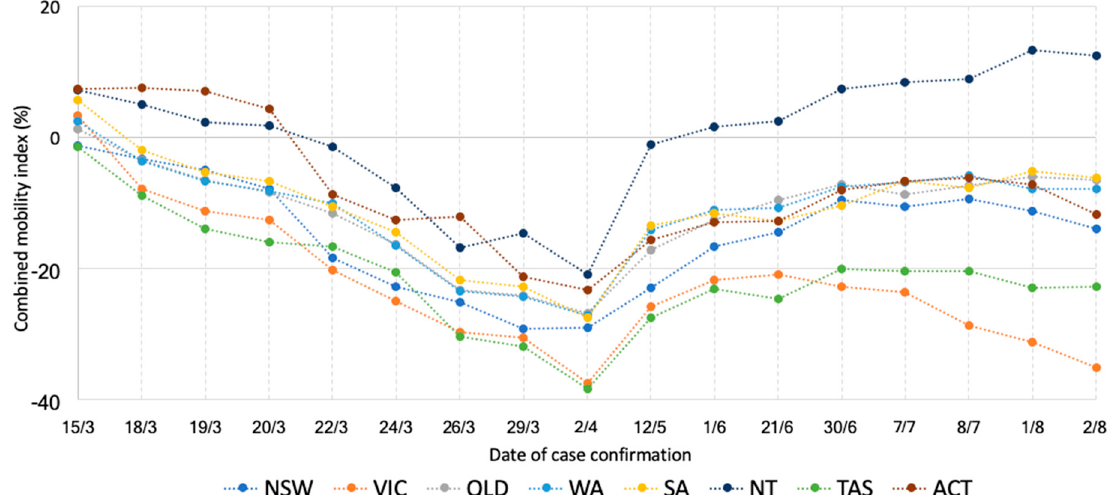
Figure 2. Combined mobility index (CMI) within 3 days after the implementation of each policy. Note: italic policies are at the state level. March-15: Outdoor gatherings limited to 500 persons; March-18: Indoor gatherings limited to 100 persons; March-19: Tasmania border closure; March-20: Strict social distancing of 4 sqm per person; March-22: New South Wales and Victoria shut down non-essential services; March-24: Queensland, West Australia, South Australia, and Northern Territory borders closure; March-26: Further lockdown of restaurants, cafes, food courts, auction houses, open house inspections; weddings restricted to 5 people; funerals to 10 people; March-29: All gatherings 2 persons only; April-2: Australian supermarkets increase in store social distancing measures; May-12: National restrictions eased; June-1: National restrictions further eased; June-21: Victoria gatherings restricted; June-30: Victoria 10 postcode lockdown; July-7: New South Wales border closure with Victoria; July-8; Victoria Stage 3 restriction; August-1: Queensland border closure with New South Wales again; August-2: Victoria Melbourne Stage 4 restriction.